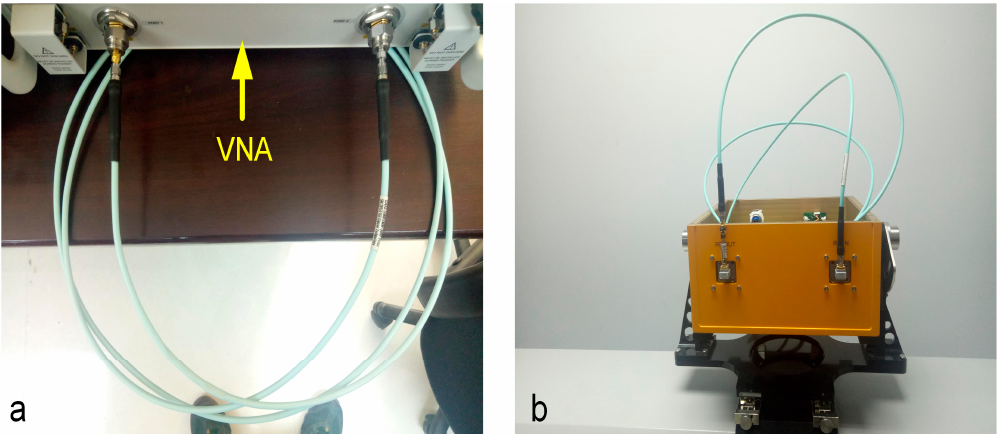
Figure 7. Phase stability test. ( a ) Testing cable delay and bending degree of cable with VNA; ( b ) The same cable will transmit interferometer directly to the receiving end for continuous sending and receiving multiple groups for phase stability test.